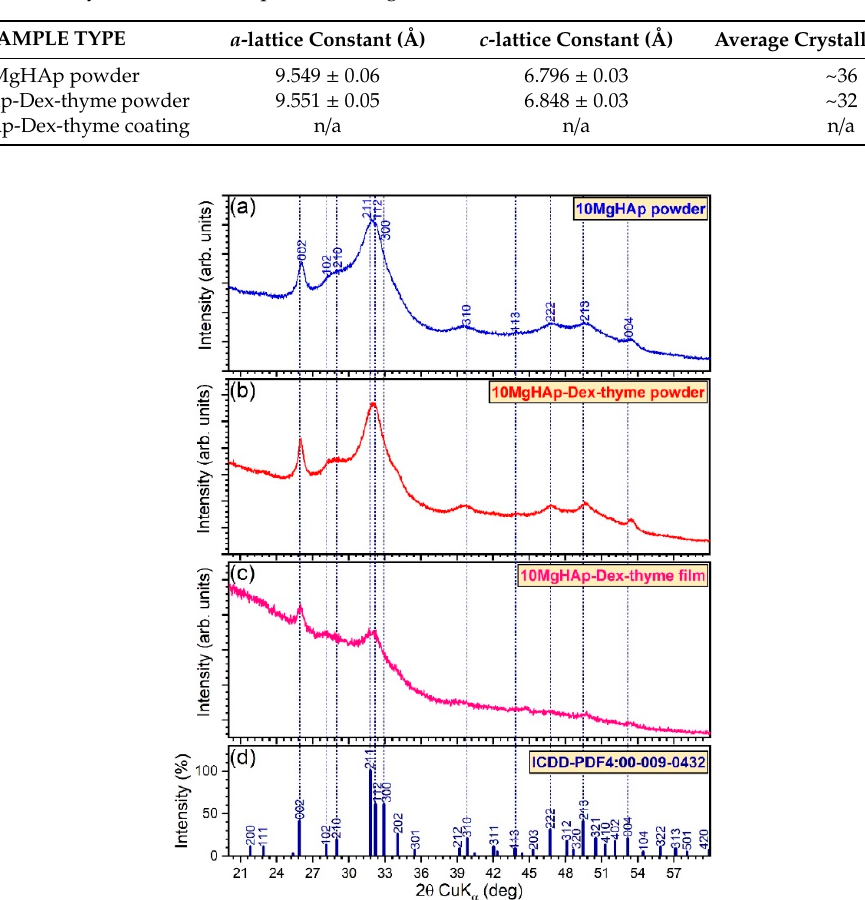
Figure 9. Comparative XRD patterns collected in the ( a , b ) Bragg–Brentano and ( c ) grazing incidence geometry for the ( a ) 10MgHAp powder, ( b ) 10MgHAp-Dex-thyme powder, and ( c ) 10MgHAp-Dex-thyme coating. ( d ) The lines of the ICDD-PDF4: 00-009-0432 reference file of hexagonal hydroxyapatite (HAp).